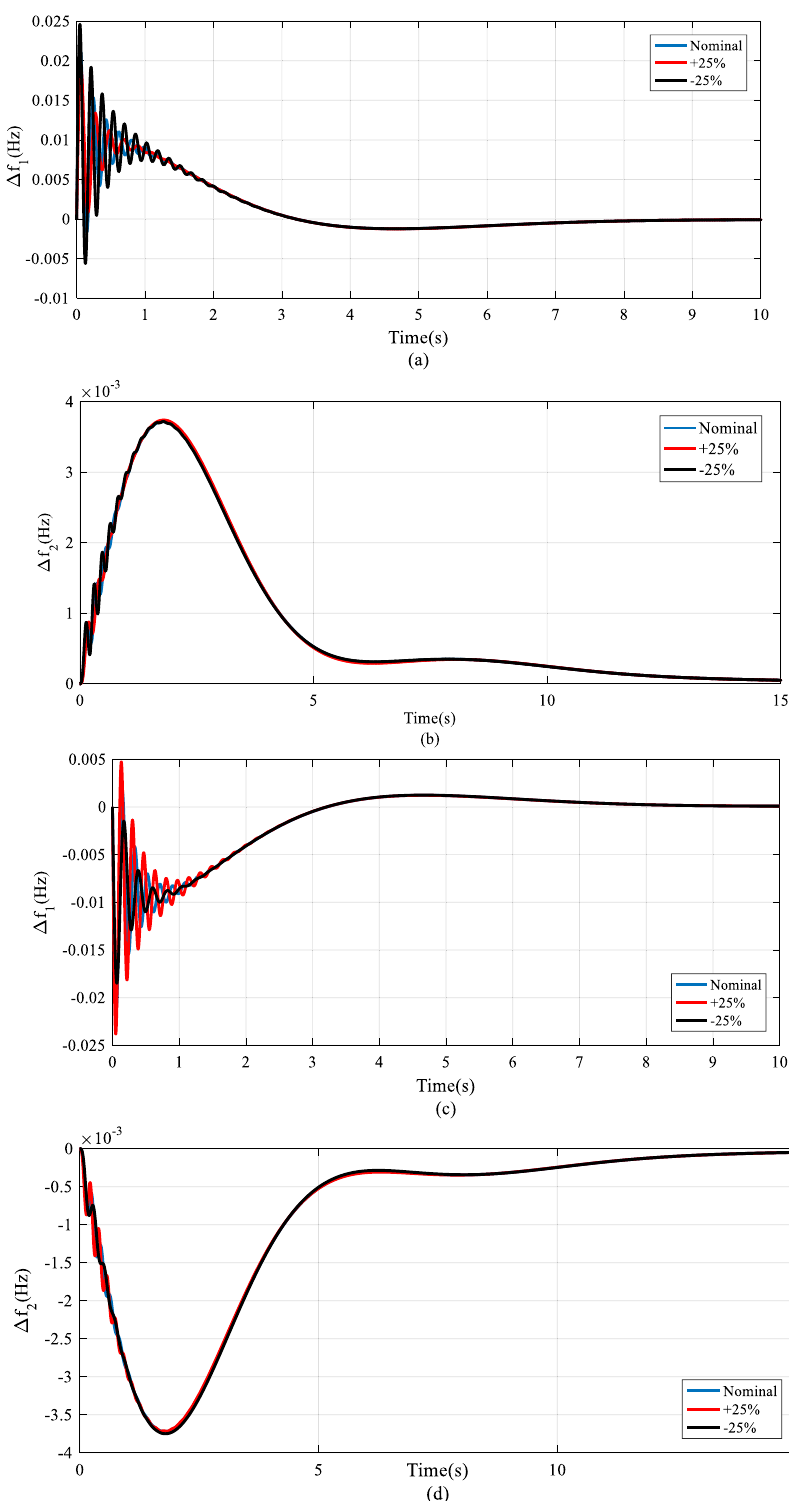
Fig. 14 Influence of system parameter variations on output responses in presence of combined controller. a Frequency deviations of area I with variation of K p ; b frequency deviations of area II with variation of K p ; c frequency deviations of area I with variation of T p ; d frequency deviations of area II with variation of T